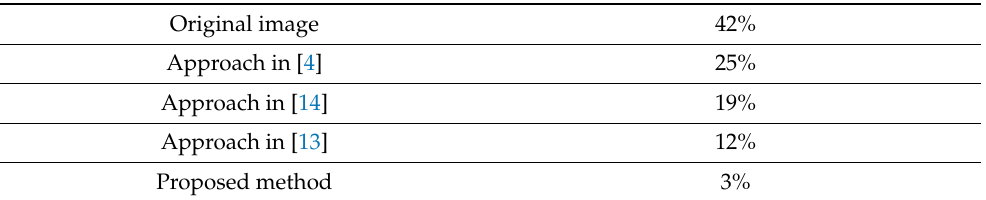
Table 2. The performance of OCR (error rate